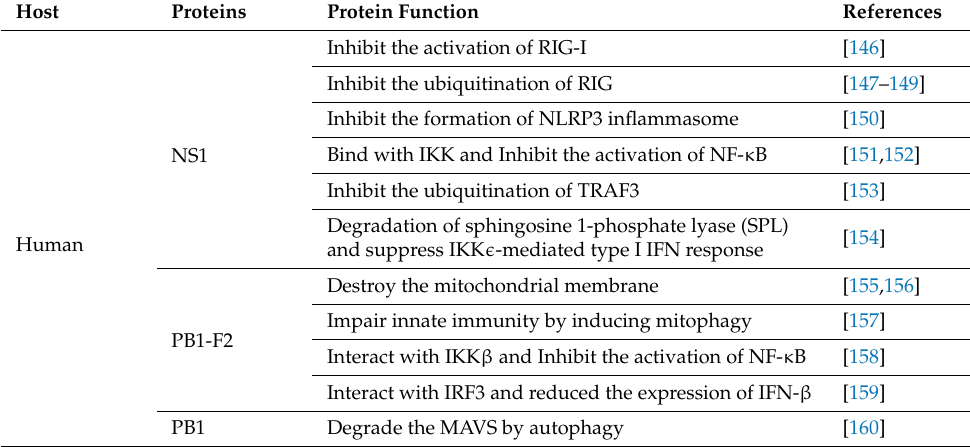
Table 1. The roles of IAV proteins in innate immune response across the